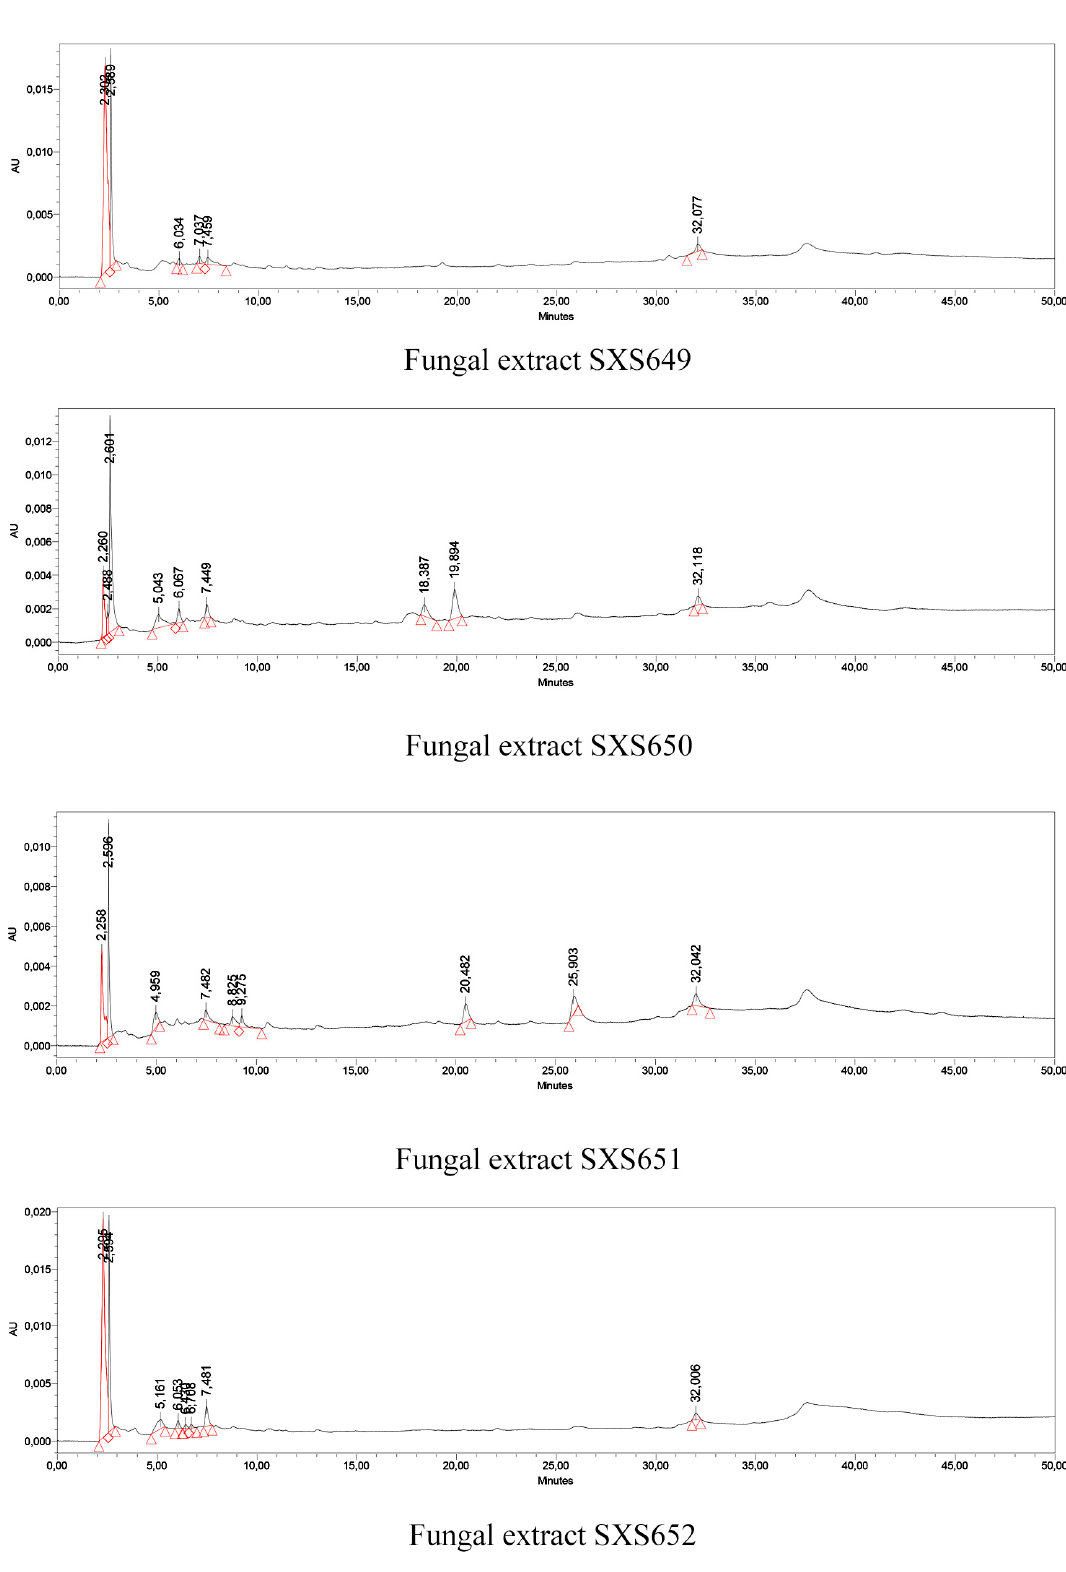
Figure 2. HPLC chromatograms of extracts of the endophytic fungi Colletotrichum sp. SXS649, Pestalotiopsis sp. SXS650, Botryosphaeriales SXS651, and Diaporthe sp. SXS652 isolates from P. rigida Kunth. Values correspond to the average of 3 repetitions.